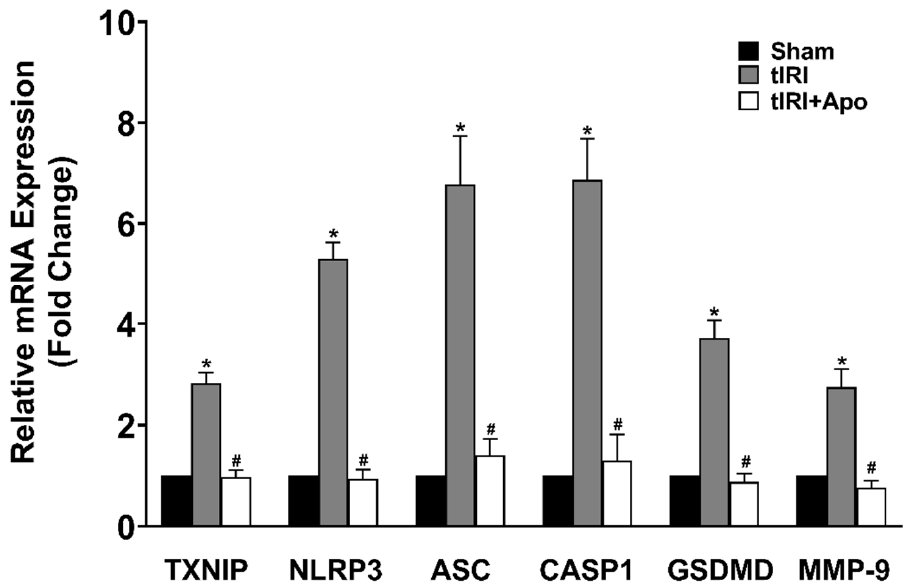
Figure 3. NOX promotes the gene expression of the NLRP3 inflammasome during tIRI in the ipsilateral testes. The relative mRNA expression of the NLRP3 pathway components was measured by the two-step method: reverse transcription (RT) followed by real-time PCR. The fold change in gene expression for tIRI and tIRI + apocynin (Apo) groups was calculated in relation to sham group using the 2 −ΔΔ Ct method. Data are presented as mean ± SD (n = 6/group), p -value < 0.05. * tIRI compared to sham and # apocynin-treated compared to tIRI.